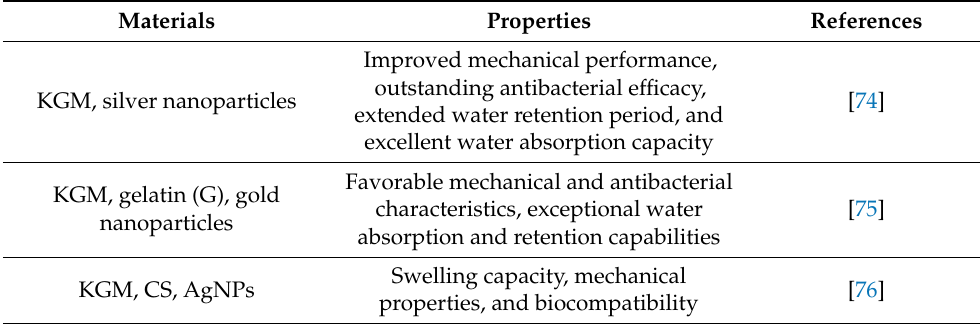
Table 1. Reductions of metallic nanoparticles for multifarious applications using